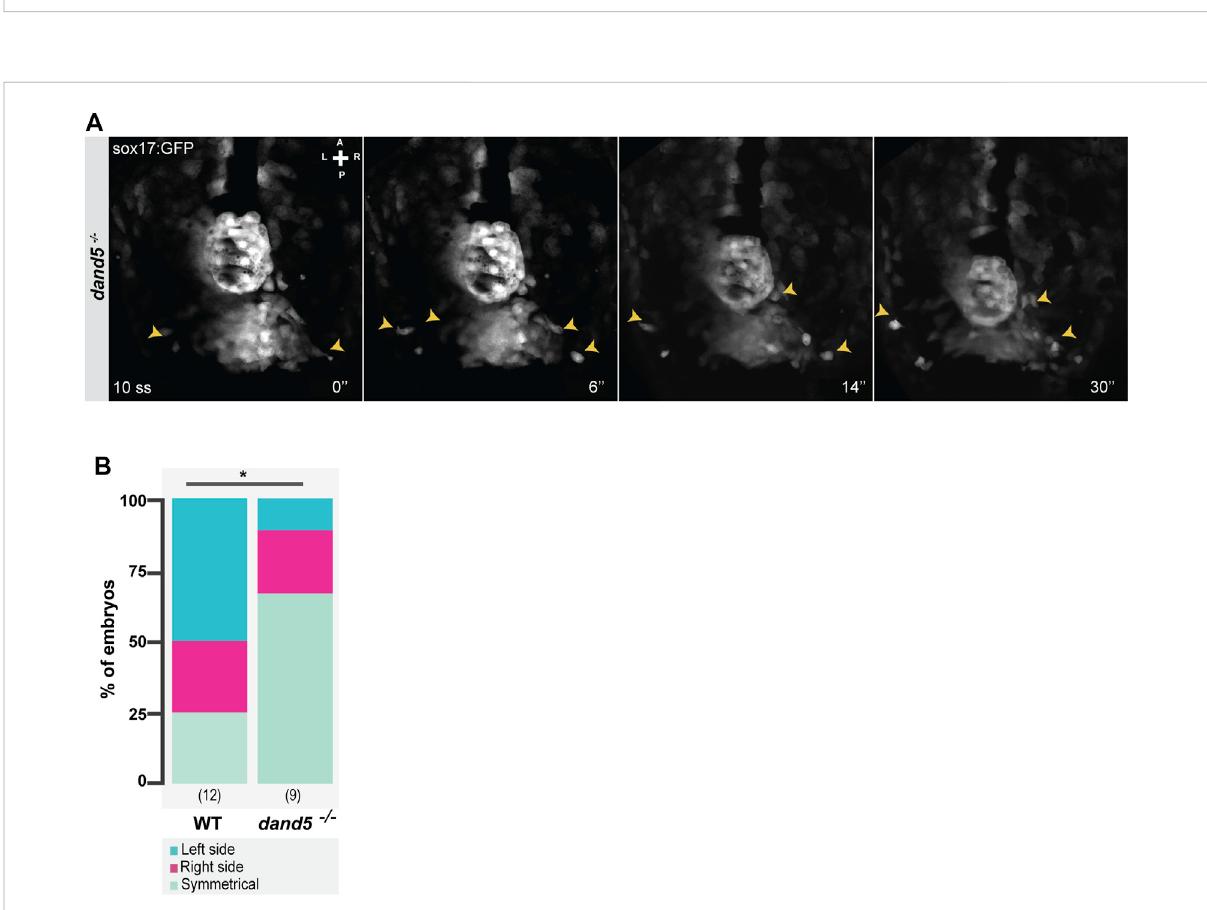
FIGURE 5 Snapshots from time-lapse live imaging of NKSTCs leaving the posterior cluster. (A) Time-lapse imaging of a dand5 − / − embryo raised on a Tg ( sox17:GFP ) background, starting at 10 ss. (B) Quanti fi cation of the fi rst side from which NKSTCs departed from the posterior cluster in WT and dand5 − / − embryos. Chi-square test. * corresponds to a p -value < 0.05. Elapsed time is indicated in minutes ( ‘ ) at the bottom right, and the axes are indicated: A, anterior; P, posterior; L, left; R, right. N is shown in